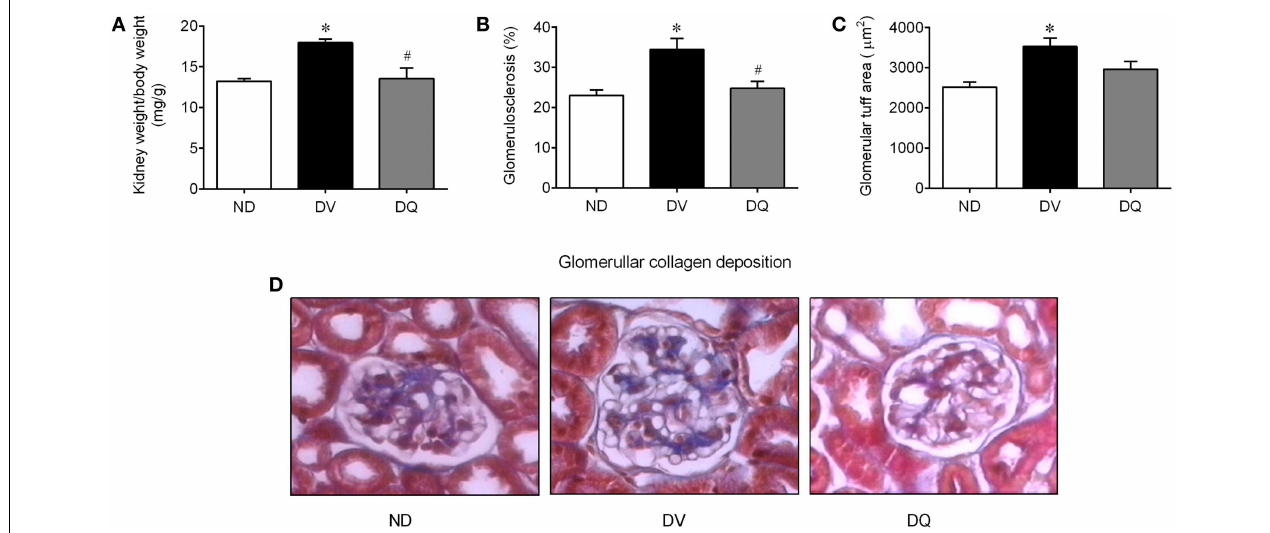
FIGURE 4 | Kidney weight (wt)/body weight ratio (A), glomerulosclerosis (B), glomerular tuff area (C) in diabetic apoE − / − mice treated with quercetin (DQ) compared with diabetic apoE − / − mice administered vehicle (DV) compared with non-diabetic apoE − / − (ND) mice. Photomicrographs (D) are representative glomerular sections (magnification of 400x), stained with Masson’s trichrome. Values are the means ± SEM for n = 6 –8 mice per group. * p < 0 . 05 vs. ND, # p < 0 . 05 vs.